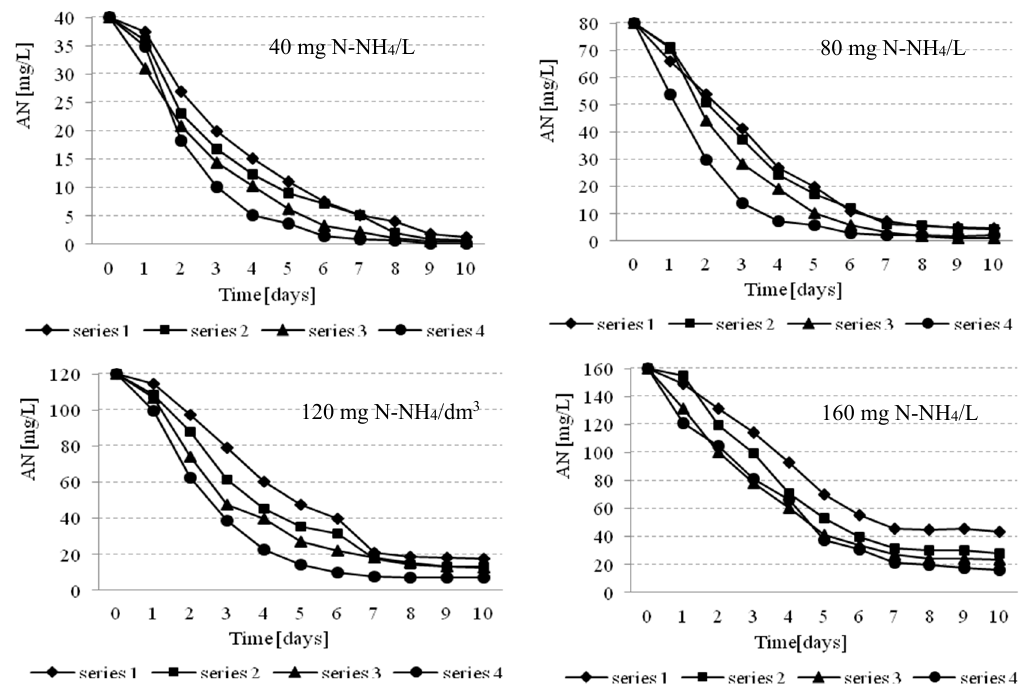
Figure 2. Changes in ammonia nitrogen (AN) concentration in experimental variants during the experimental period.